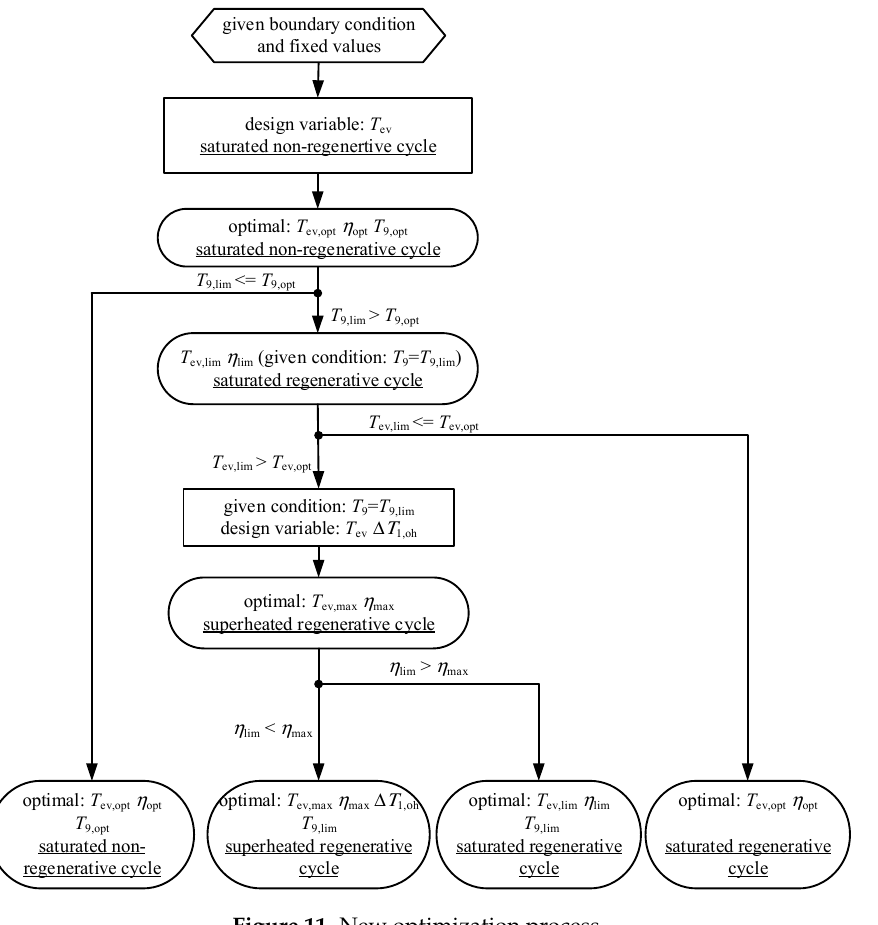
Figure 11. New optimization process.